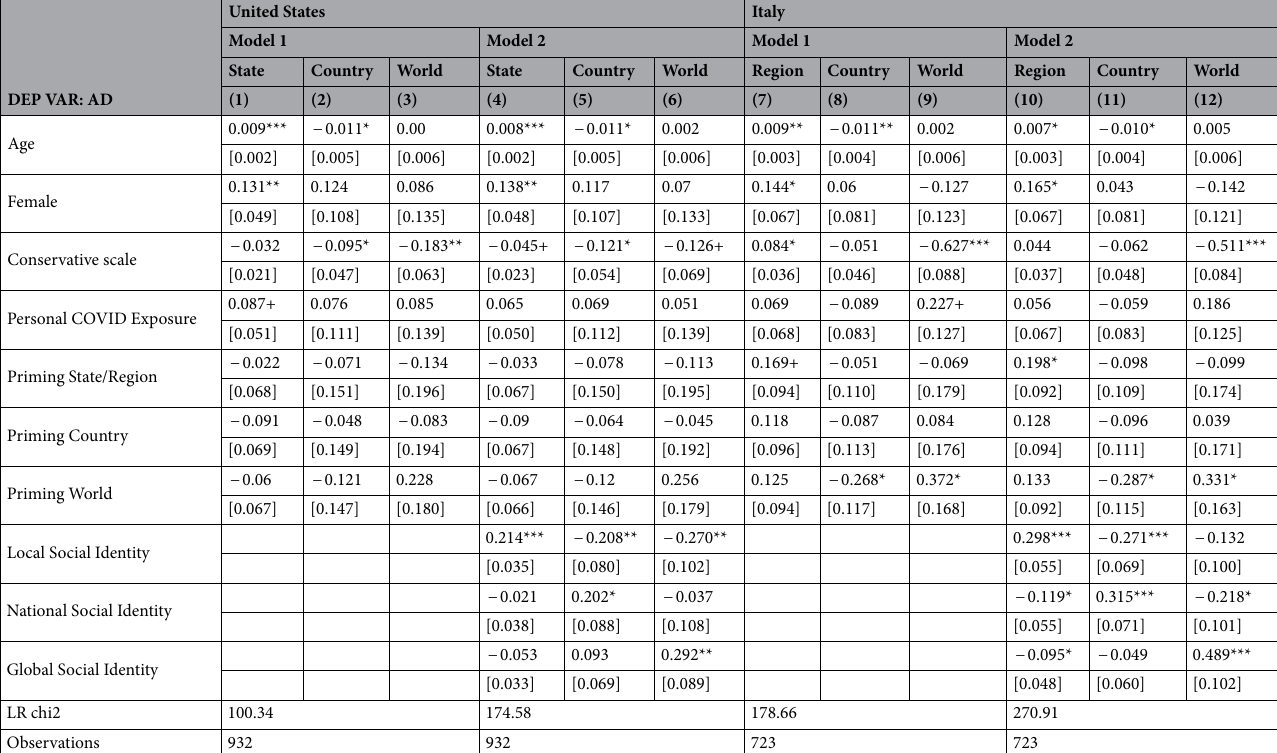
Table 2. Econometric analysis of Aggregate Donations ( AD ). We fit multivariate Tobit models to estimate AD for each of the three charities. AD is the overall amount of donations to each charity, combining both the extensive margin (which charity is chosen) and the intensive margin (conditional donations to each charity). In addition to the covariates reported above, all models also include controls for education level, indicator for respondent’s location size, income, whether the individual reported an income loss because of COVID-19, macro-region dummies (South/North for Italy and South/Midwest/Northeast/West for the U.S.), an indicator identifying individuals who were either born abroad or whose parents were born abroad, and county-level exposure to COVID-19. The full regression output is reported in the Supplementary Table 5a. Variables are defined in Supplementary Table 1. Standard errors are in brackets. *** p < 0.001, ** p < 0.01, * p < 0.05, + p <